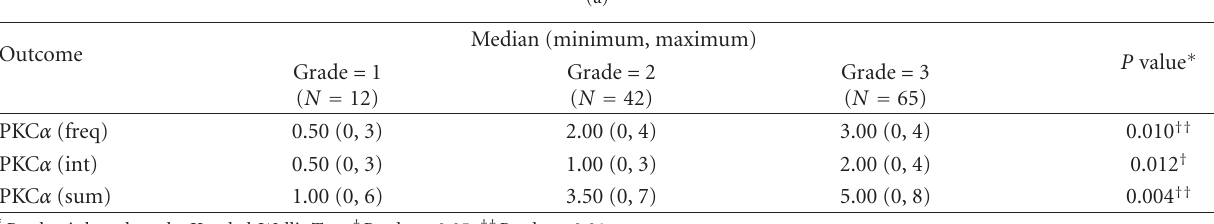
Table 5: (a) High tumor grade correlates with elevated PKC α expression. (b) PKC α and tumor grade is correlative in AA but not in Caucasian patients.